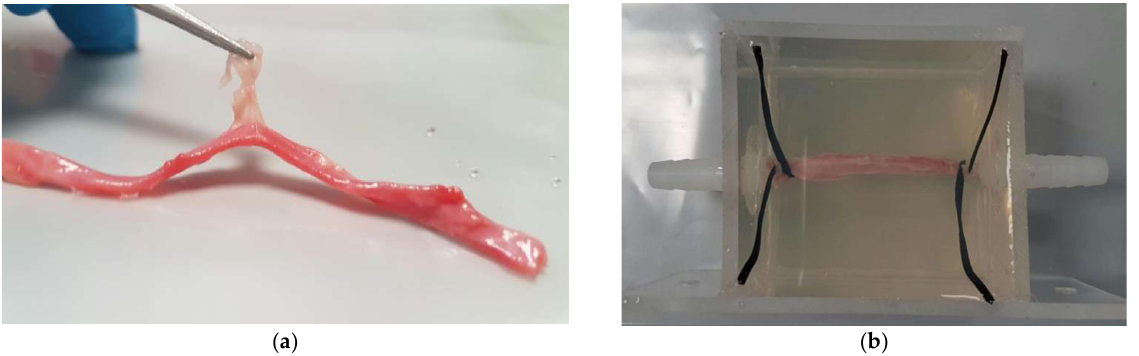
Figure 1. Illustration of an artery ( a ) extracted from the porcine leg and ( b ) connected with fluid connector and embedded in the polyacrylamide gel phantom.